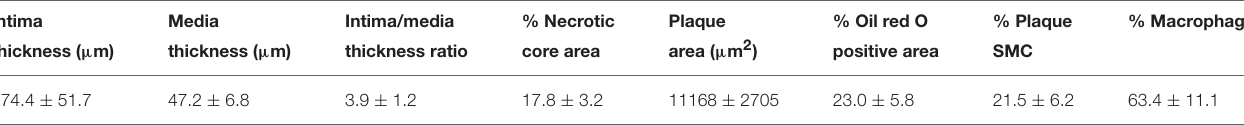
TABLE 1 | Plaque composition from thoracic aorta sections of ApoE − / − mice fed with a lipid-rich diet for 16–20 weeks.